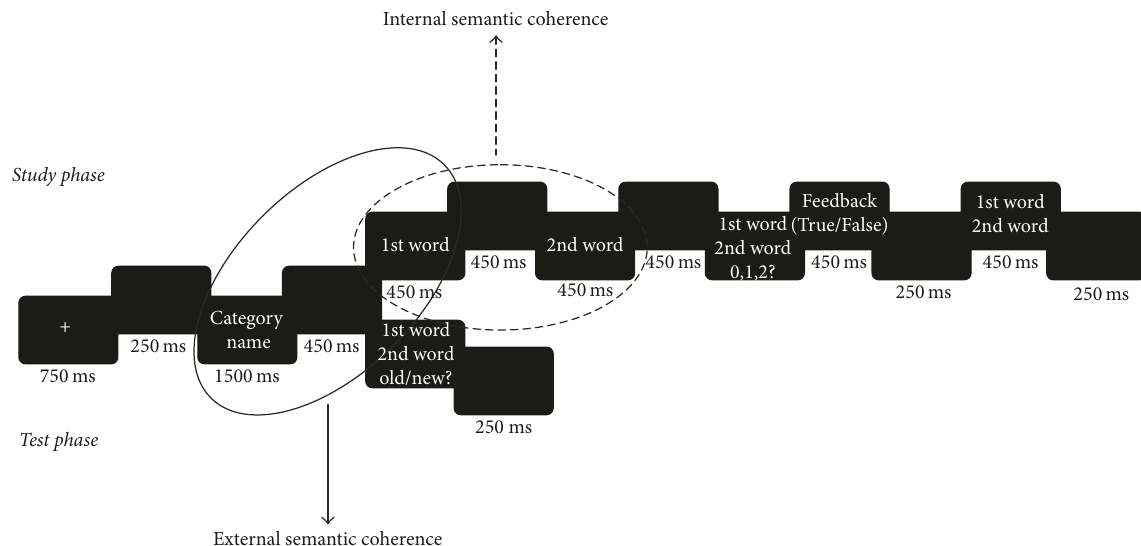
Figure 2: Procedure at study and test